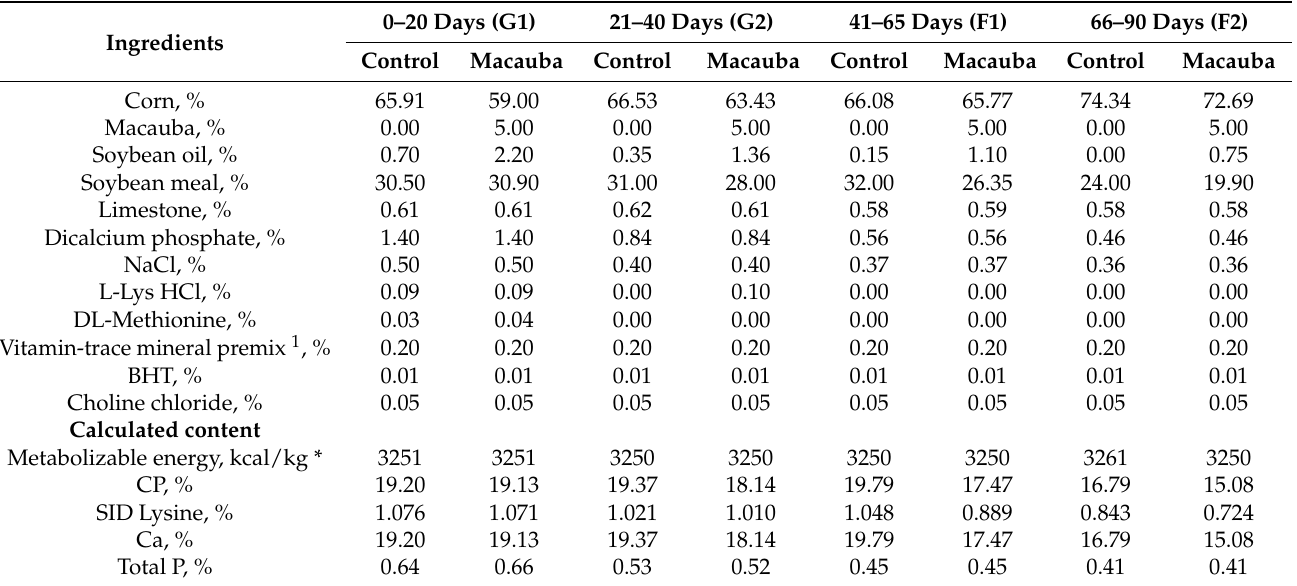
Table 1. Experimental diets ingredients and composition for the corn–soybean meal diets without (control) or with 50 g/kg of macauba pulp inclusion